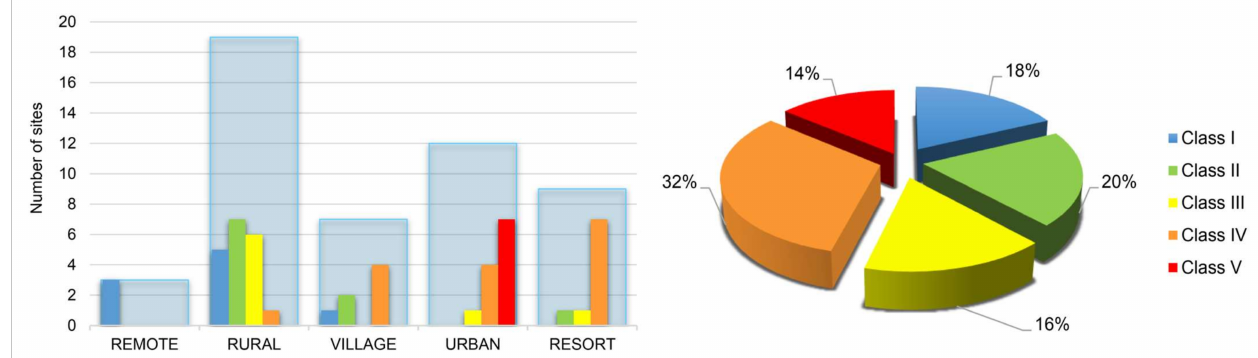
Figure 4. Coastal scenery percentage distribution by class and by type of beach along the study area. Blue rectangles indicate the total number of sites within each beach